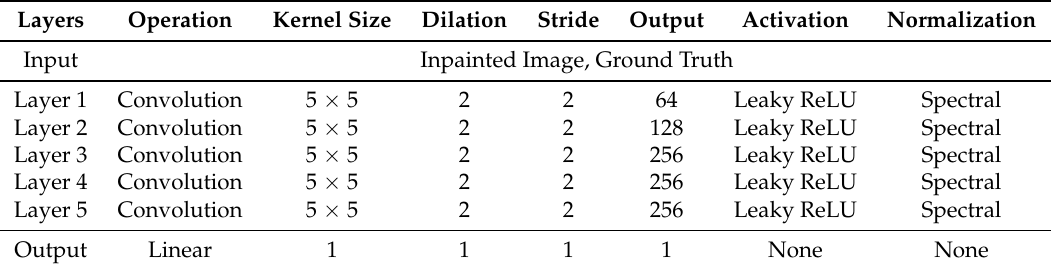
Table A3. Discriminator